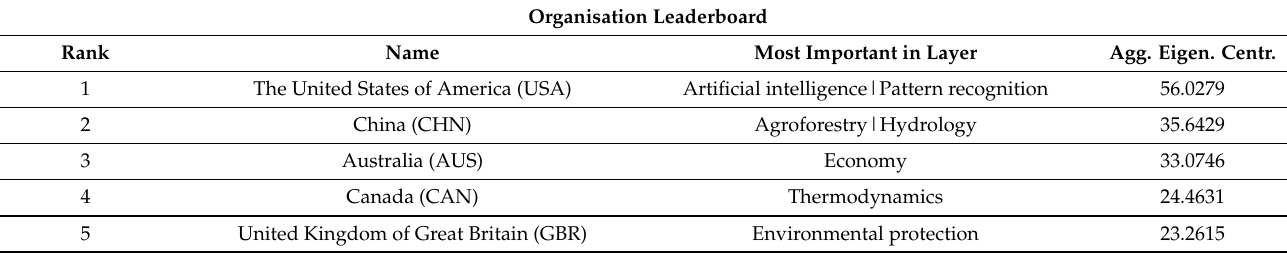
Figure 5. Multilayer institutional network aggregated at the country level from the atmospheric sciences and meteorology layers and the extension of them, atmospheric sciences—meteorology. Table 3. Leaderboards of the top 5 institutes and authors contributing to